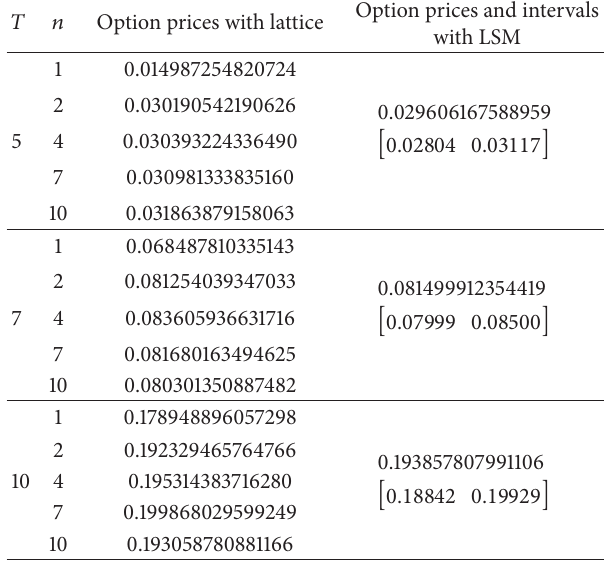
Table 2: Numerical results for Example